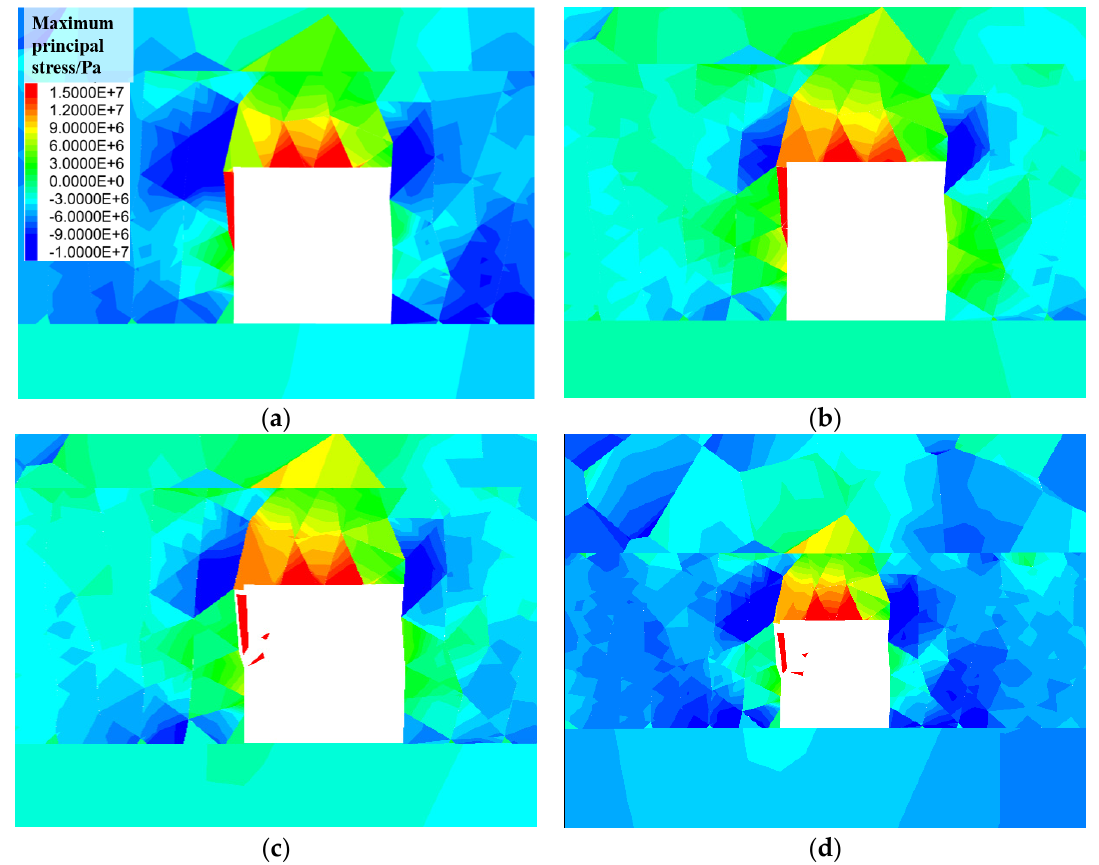
Figure 6. Evolution of maximum principal stress around the roadway: ( a ) 0 ms; ( b ) 100 ms; ( c ) 200 ms; ( d ) 300 ms.